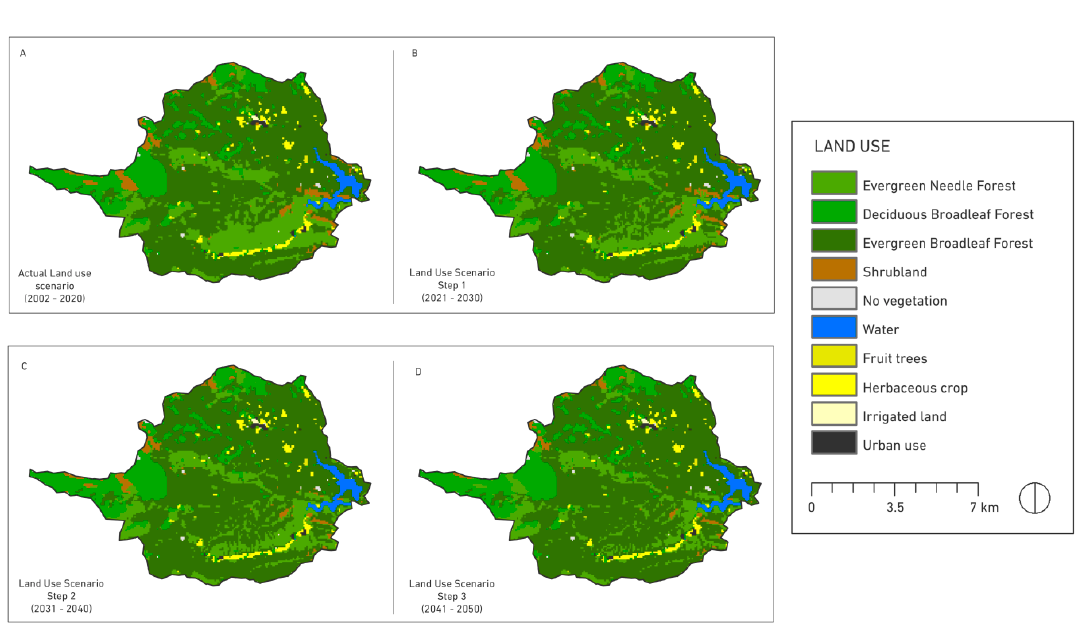
Figure 4. Land-use change scenarios 2002–2050. ( A ) Actual land-use scenario. ( B ) Step 1 =